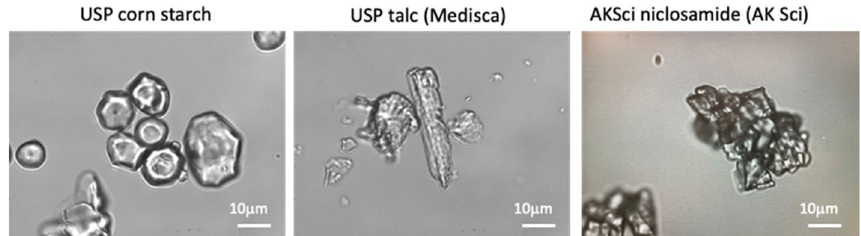
Fig. 11 Optical microscope images of the main components of Yomesan powder: corn starch (Lab Alley, TX); USP talc (magnesium silicate) (Medisca); anhydrous pure niclosamide (AK Sci) as aggregates of small particles. 40